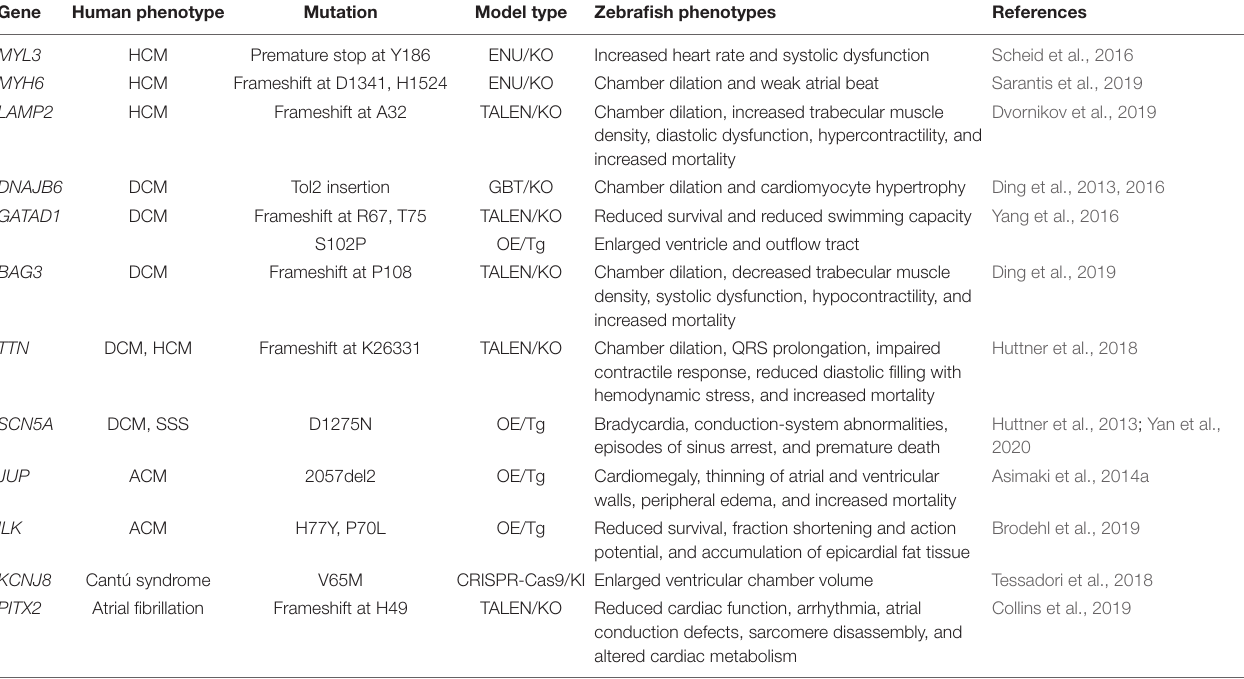
TABLE 1 | Adult zebrafish models of inherited